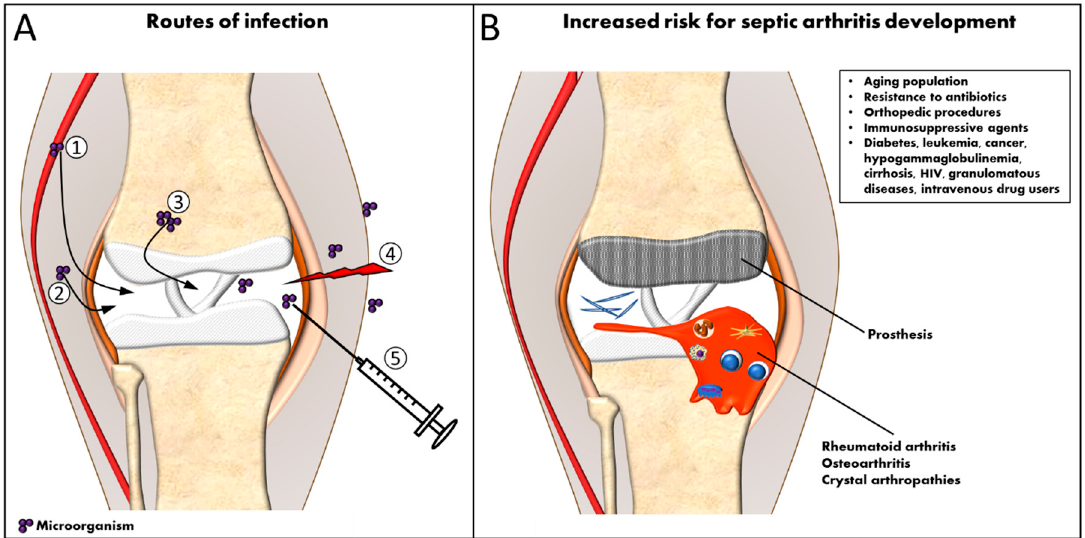
Figure 1. Routes of bacterial infection and risk factors for septic arthritis development. ( A ) Bacteria can access the joint through 5 routes: (1) by hematogenous spread; (2) from an adjacent infected tissue; (3) through infected bones; (4) as a consequence of trauma or (5) during diagnostic procedures. ( B ) Additionally, some risk factors are related to septic arthritis such as presence of other rheumatic or immunosuppressive diseases, prosthetic surgery and higher age.